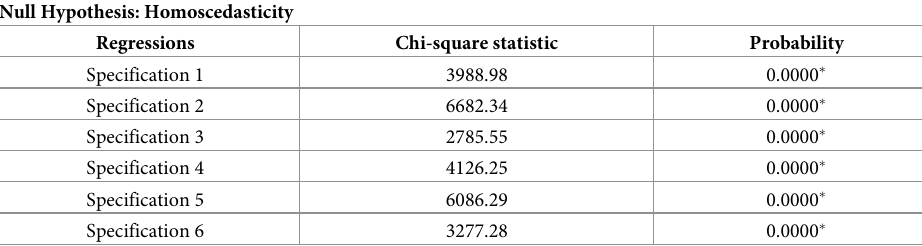
� and �� show significance levels at 1% and 5%, respectively.